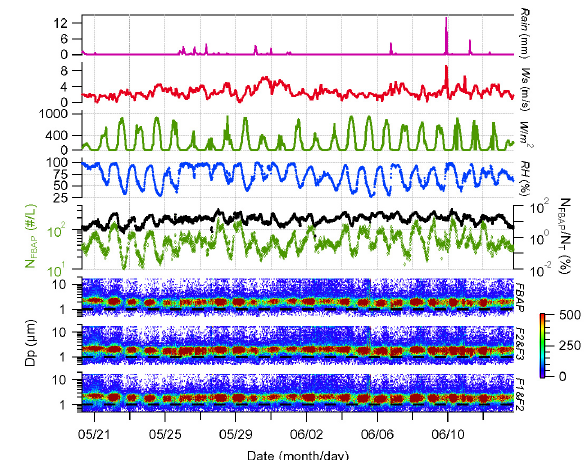
Fig. 12. WIBS-4 fluorescence data for a selected time period dur- ing spring season in comparison with meteorological data mea- sured at the same time. The lower panels represent different com- binations of fluorescent channels (F1&F2: FL1 280 & FL2 280, F2&F3: FL2 280 & FL2 370, FBAP: FL1 280 & FL2 370). The upper panels show, from bottom to top, number concentration of FBAP (left) and ratio of FBAP to all particles (right) measured by WIBS (0.8–16µm), relative humidity (%), global solar radiation (Wm − 2 ) , wind speed (ms − 1 ), and precipitation (mm).